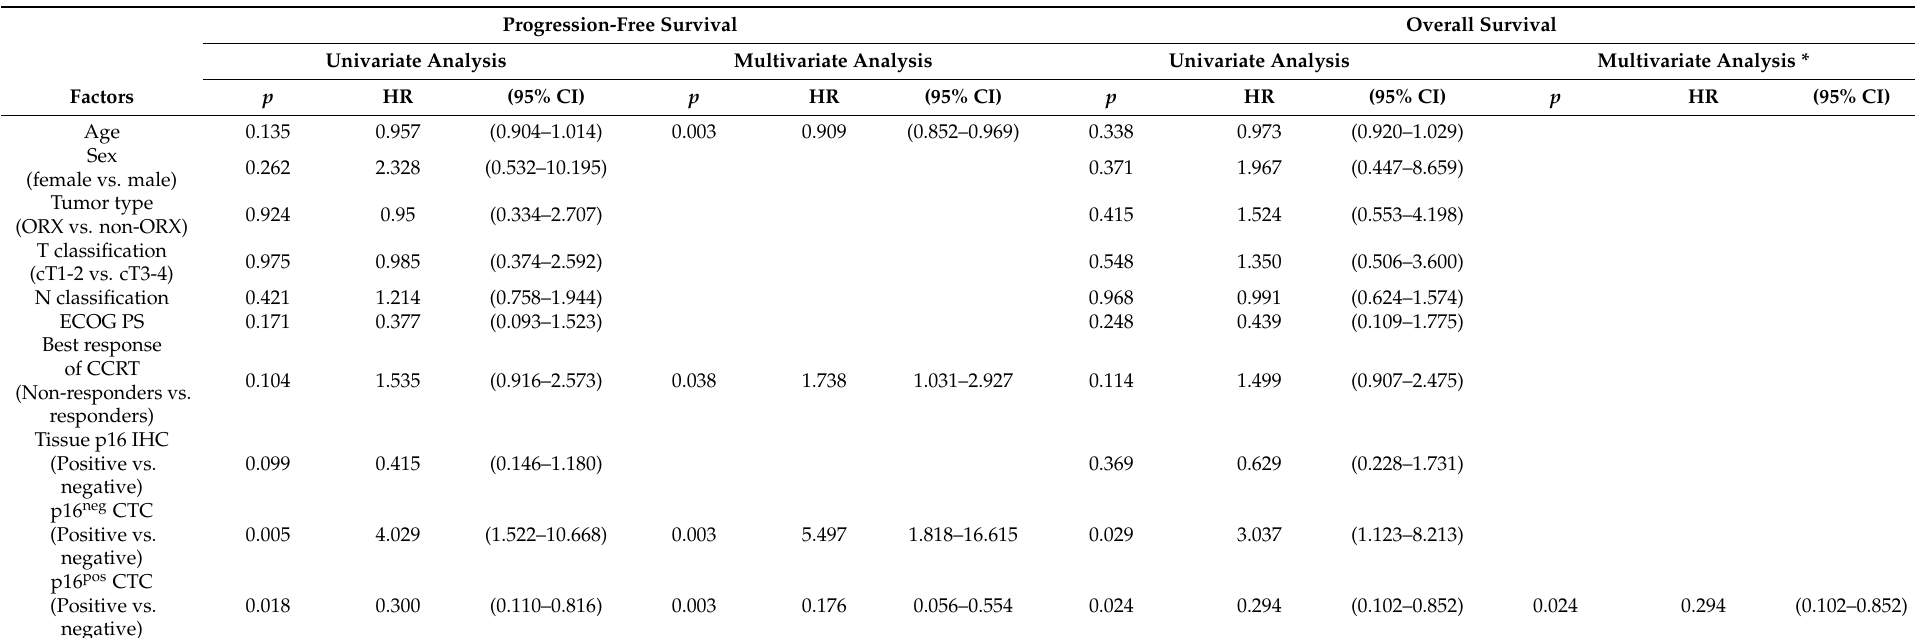
Table 3. Univariate and multivariate Cox regression